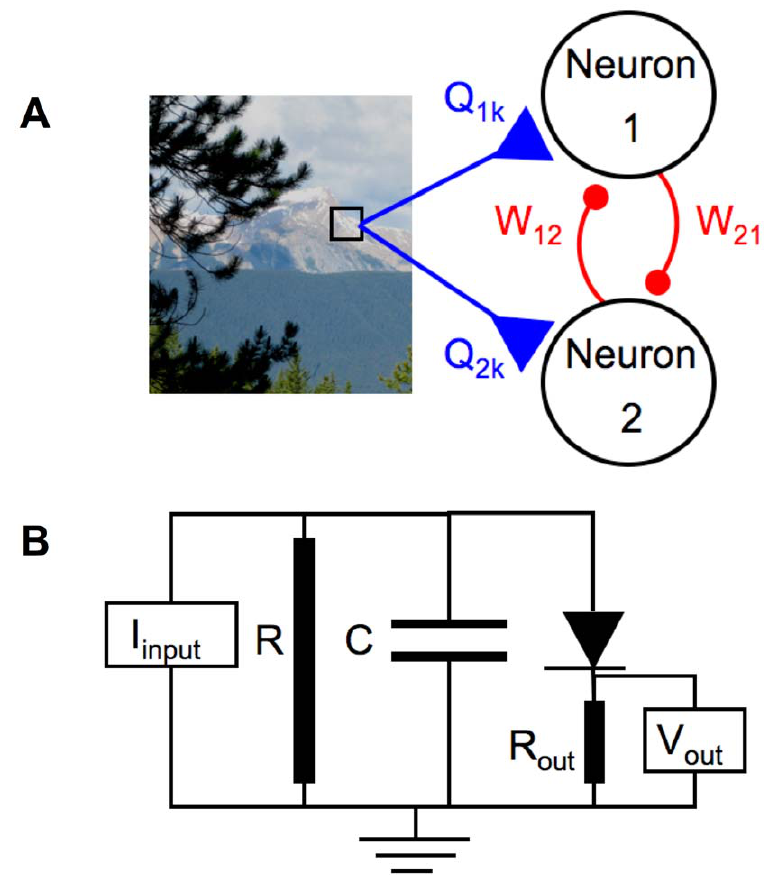
Figure 1. SAILnet network architecture and neuron model. (A) Our network architecture is based on those of Rozell et al. [39] and Fo¨ldia´k [15,37], and inspired by recent physiology experiments [21,23,47]. Inputs X k to the network (from image pixels) contact the neuron at connections (synapses) with strengths Q ik , whereas inhibitory recurrent connections between neurons [23] in the network have strengths W im . The outputs of the neurons are given by y i ( t ) ; these spiking outputs are communicated through the recurrent connections, and also on to subsequent stages of sensory processing, such as cortical area V2, which we do not include in our model. (B) Circuit diagram of our simplified leaky integrate-and-fire [30] neuron model. The inputs from the stimulus with pixel values X k , and the other neurons in the network, combine to form the input current Q ik X k { P W im y m ( t ) to the cell. This current charges up the capacitor, while some current can leak to ground through a resistor in I input ( t ) ~ P k m = i parallel with the capacitor. The resistors are shown as cylinders to highlight the fact that they model the collective action of ion channels in the cell membrane. The internal variable evolves in time via the differential equation for voltage across our capacitor, in response to input current I input : du i ( t ) = dt z u i ( t ) ~ I input ( t ) , which we simulate in discrete time. Once that voltage exceeds threshold h i , the diode, which models neuronal voltage- gated ion channels, opens, causing the cell to fire a punctate action potential, or spike, of activity. For sake of a complete circuit diagram, the output is denoted as the voltage, V out , across some (small: R out % R ) resistance. After spiking, the unit’s internal variable returns to the resting value of 0 , from whence it can again be charged